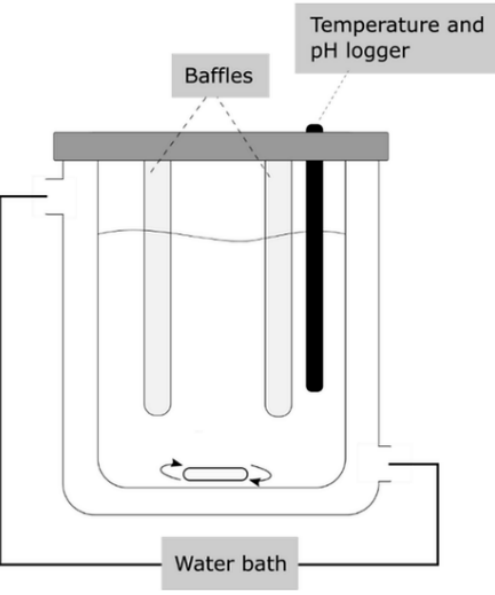
Figure 2. Sketch of the experimental set-up used for crystallization of nickel sulfate. Batch reactor, temperature-controlled by circulating water bath. Proper mixing was ensured by magnetic stirring and baffles attached to the lid.